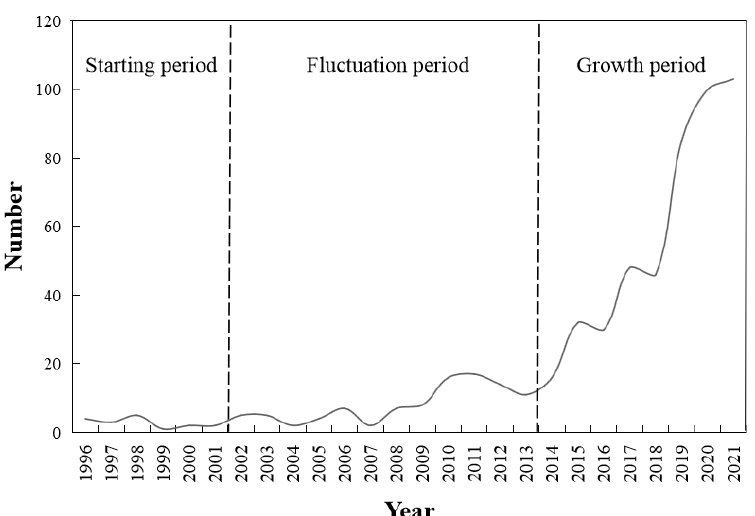
Figure 1. Annual number of publications on urban tourism from 1996 to 2021.